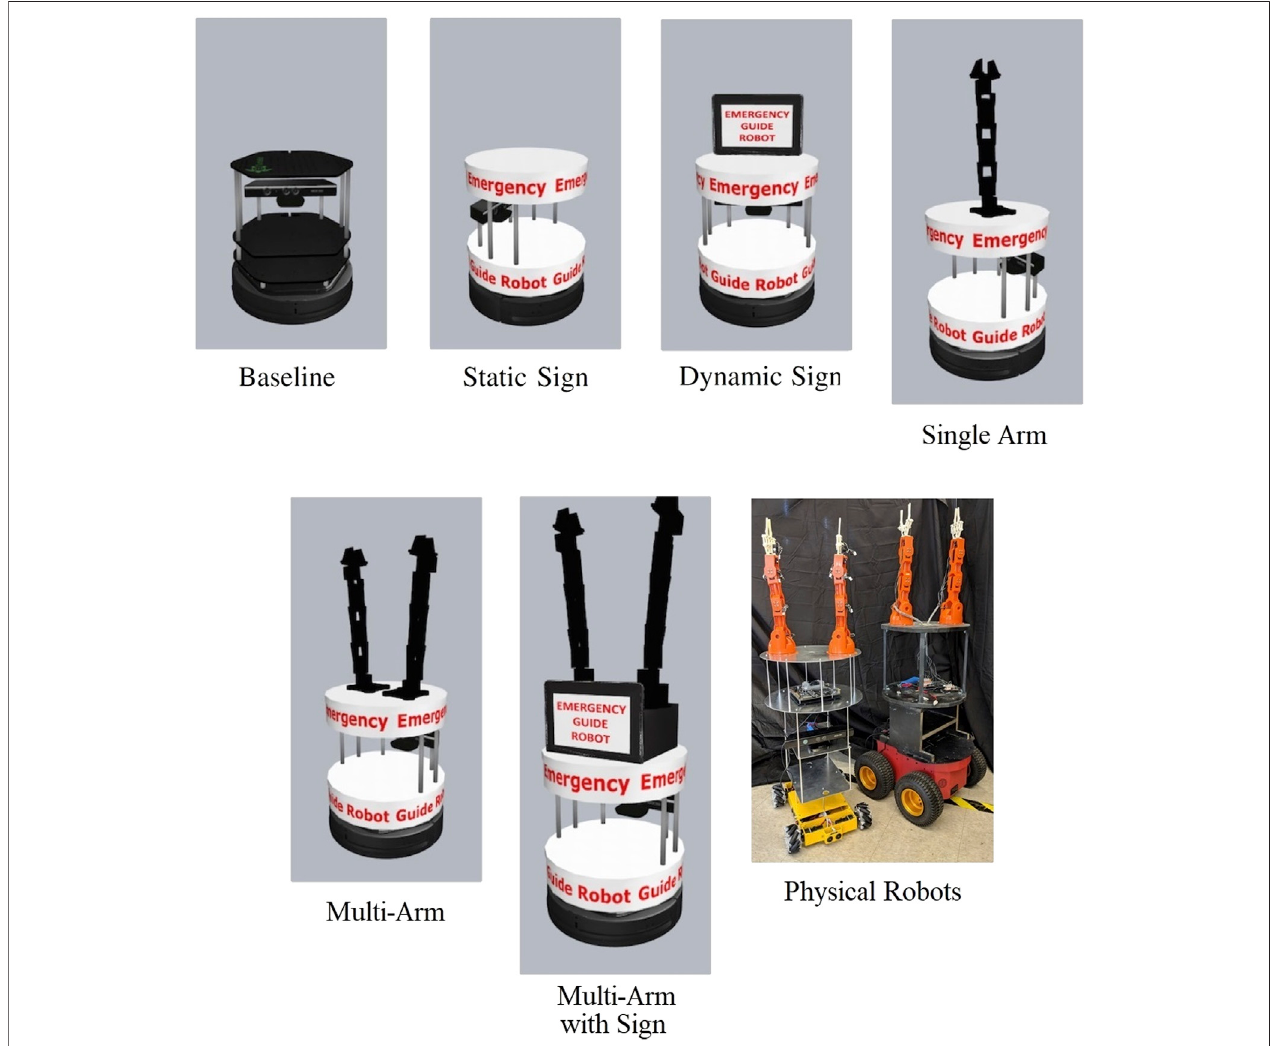
FIGURE 6 | Different robot designs evaluated for its ability to communicate guidance directions. The physical robots are based on the multi-arm design.